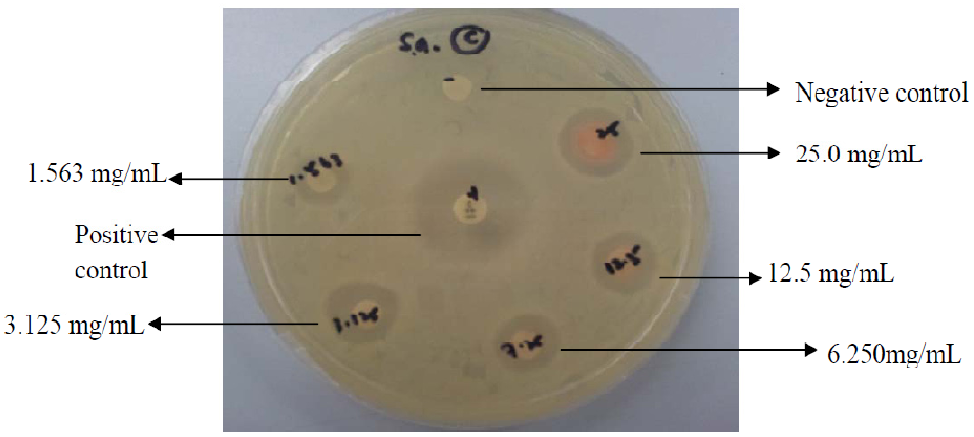
Figure 5. Inhibition zones of C-5-bromo-2-hydroxyphenylcalix[4]2-methylresorcinarene ( I ) against MRSA using the disc diffusion assay tested at concentrations of two-fold dilution. The highest concentration of tested would correspond to 250 μ g.